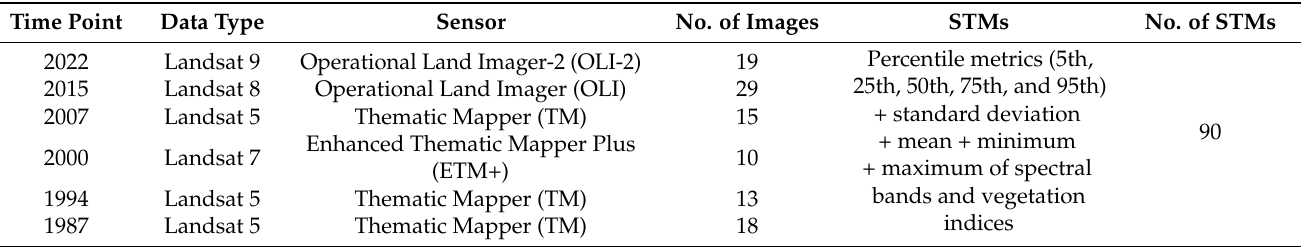
Table 2. Details of used Landsat imagery and STMs for multi-temporal land use/cover